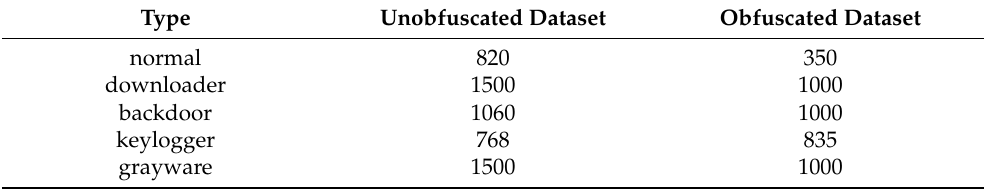
Table 1. Number of API sequence samples of various malware in the dataset.